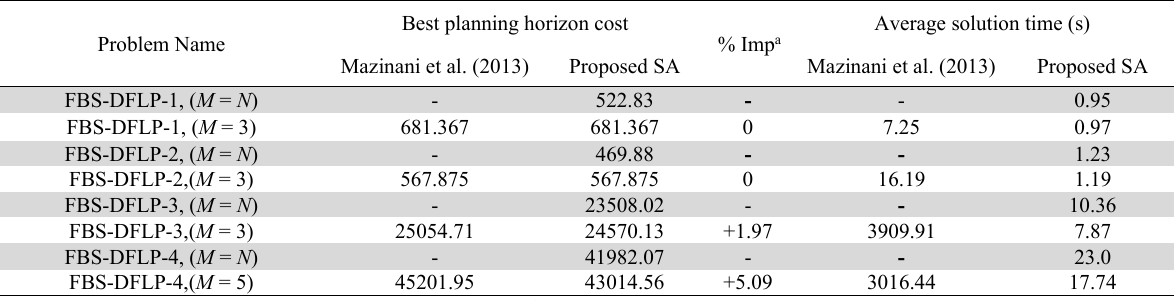
Table 5 Comparison of planning horizon cost and CPU timing of the proposed SA heuristic for DFLP with FBS based test